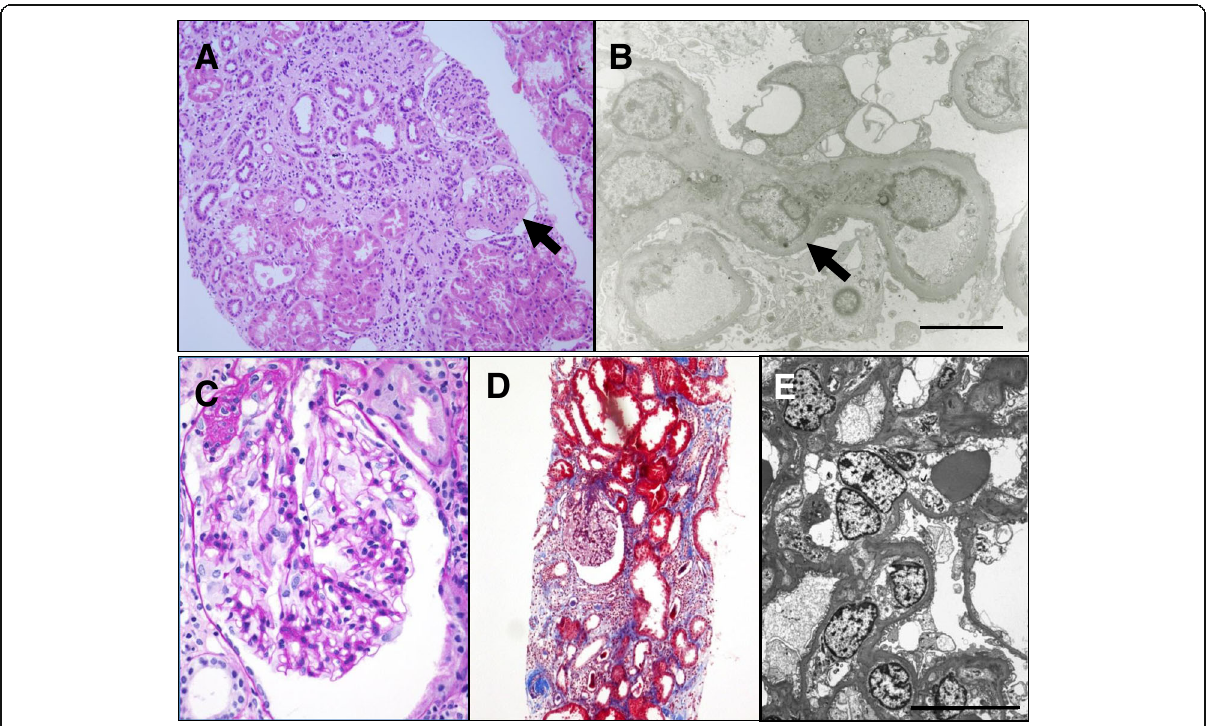
Fig. 2 Renal pathological findings of 2 patients with multicentric carpotarsal osteolysis syndrome. In Patient 1, light microscopy ( a ) shows a glomerulus with segmental sclerosis (arrow), tubular atrophy, and interstitial fibrosis (hematoxylin and eosin, × 200). Electron microscopy ( b ) reveals wide effacement of foot process (arrow). (scale bar = 10 μ m) In Patient 2, light microscopy shows a glomerulus perihilar segmental sclerosis ( c , periodic acid – Schiff, × 400) and mild to moderate tubulointerstitial fibrosis with tubular atrophy ( d , Masson ’ s trichrome, × 200), and electron microscopy ( e ) reveals wide effacement of the foot processes with occasional villous transformation and hydropic change of podocytes. (scale bar = 10 μ